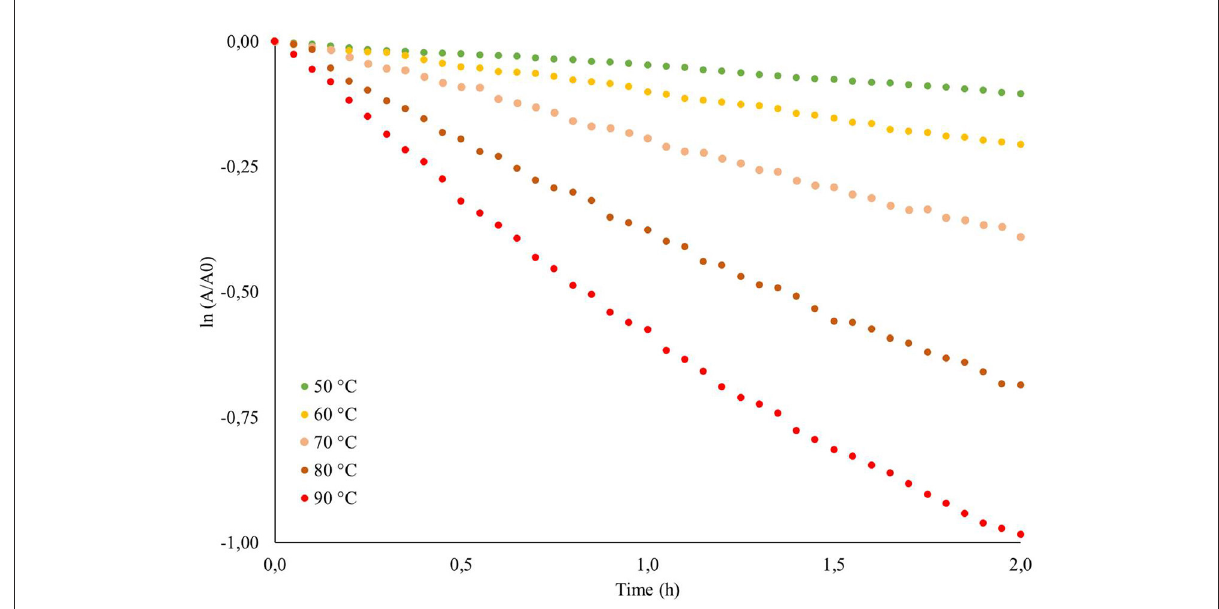
FIGURE6 ln ( A/A 0 ) of the red pigments produced in the submerged cultivation from Monascus ruber CCT 3802 as a function of the heat treatment time under different temperatures.